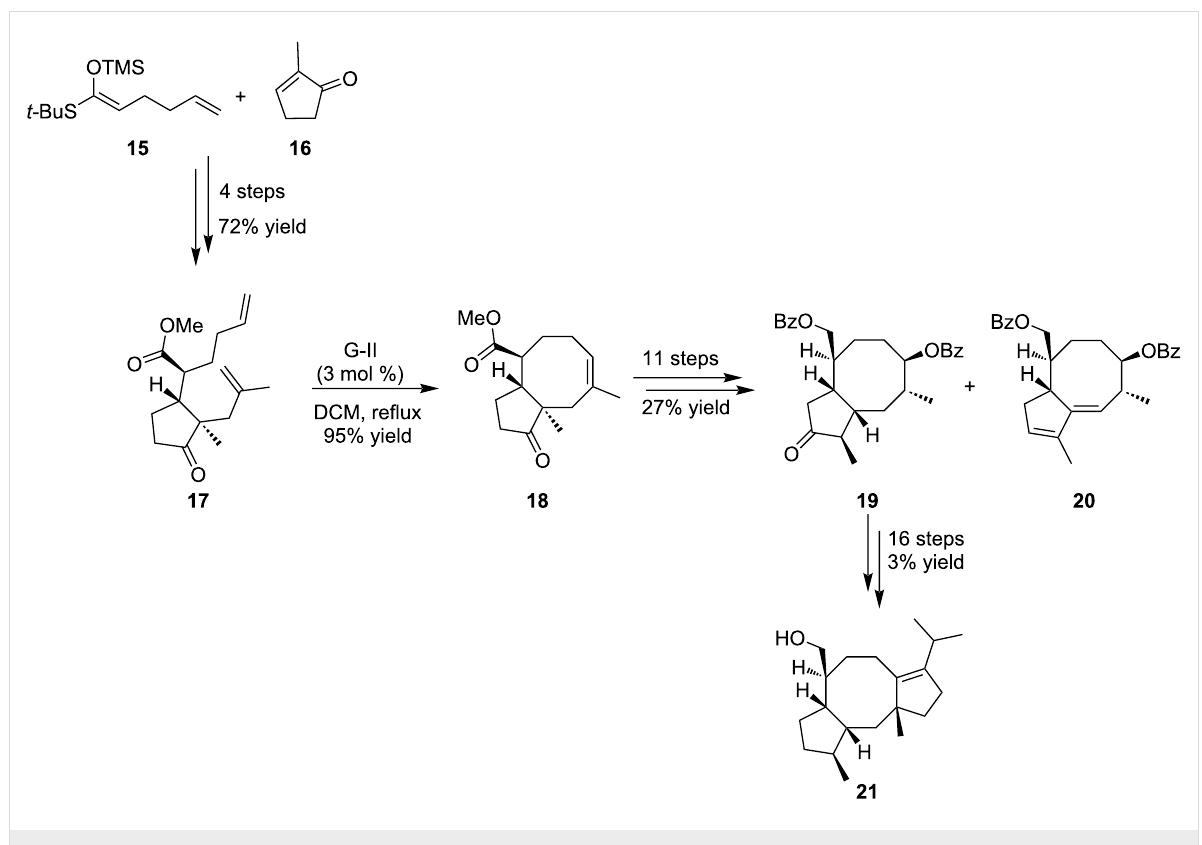
Scheme 2: Synthesis of the core structure 21 of ophiobolins and